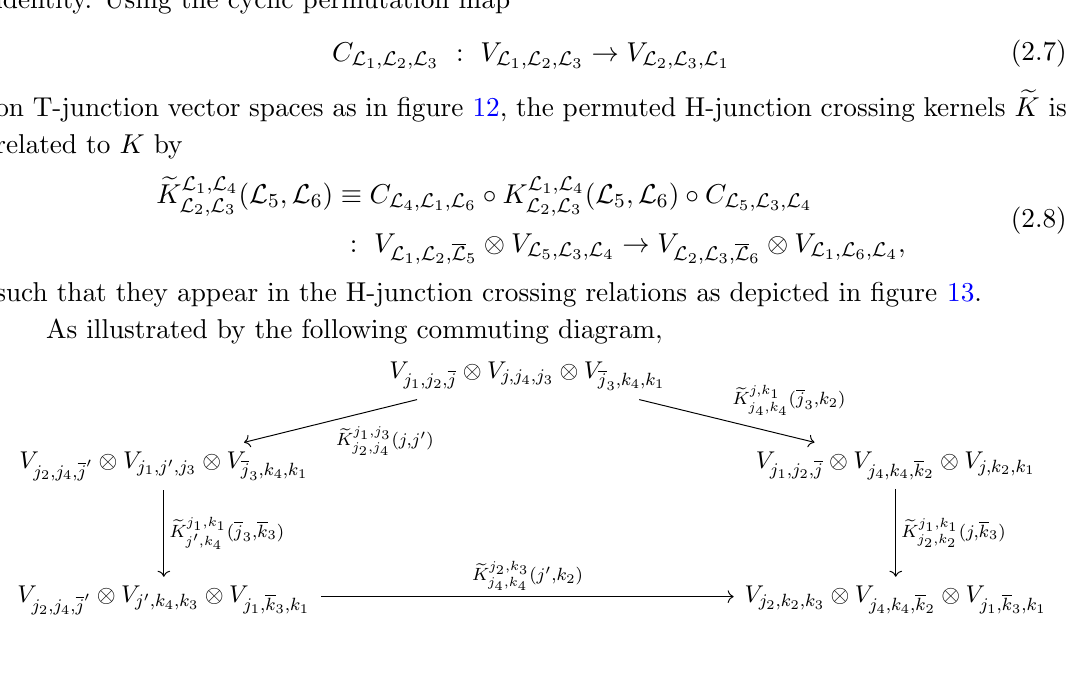
Figure 12 . The cyclic permutation map on a